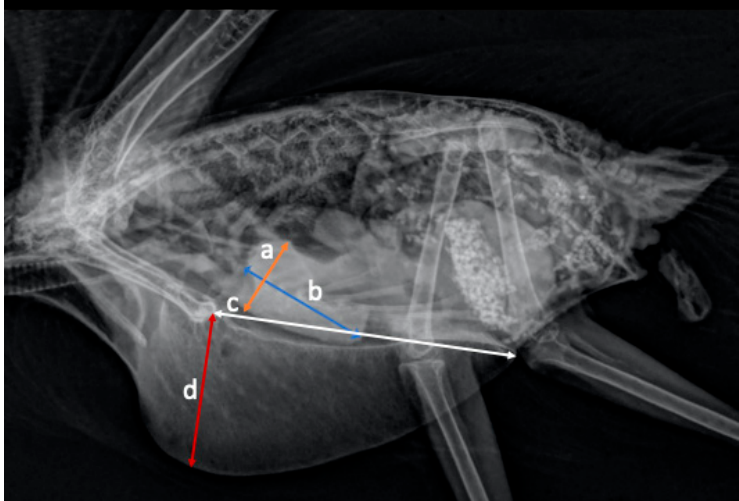
Figure 2. Laterolateral (LL) projection and measurements in a radiograph of a wild galah: ( a ) widest point of the heart (orange); ( b ) length of the heart at height of the aorta and pulmonary artery to the apex (light blue); ( c ) length of the sternum from the insertion of the coracoid to the caudal edge (white); ( d ) depth of the sternum, 90° from the junction of the coracoid to the sternum (red).